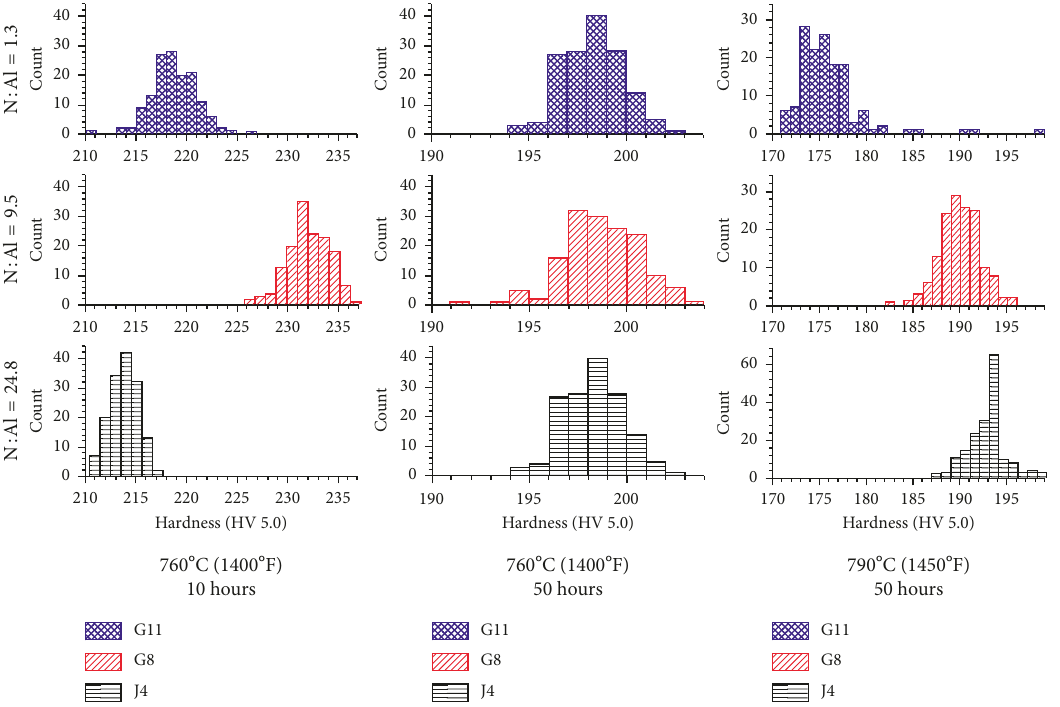
Figure 12: Analysis of the N : Al ratio on tempering behavior for specific casts of Grade 91 steel. Note that although steel J4 starts with the lowest initial hardness value, as demonstrated in the 760 ° C (1400 ° F) for 10 hours experiments, it exhibits the highest resistance to tempering and a more consistent (i.e., lower standard deviation) hardness for each examined tempering treatment.